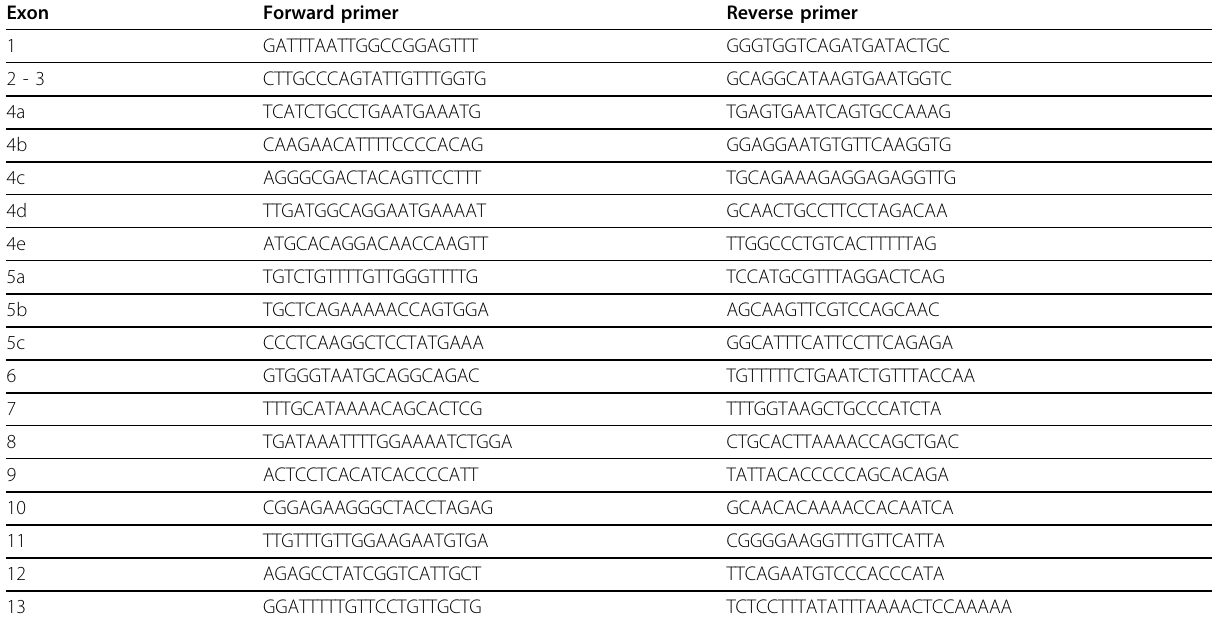
Table 1 PALB2 gene primers